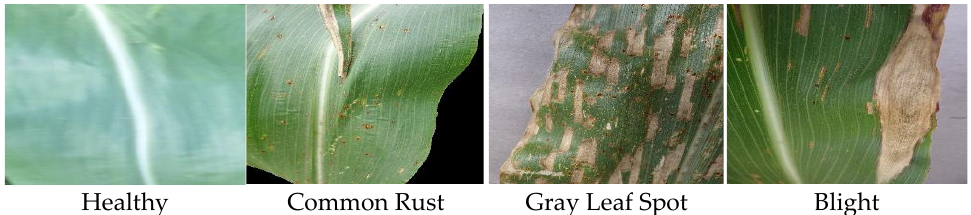
Figure 6. Sample images from the corn leaf disease dataset.